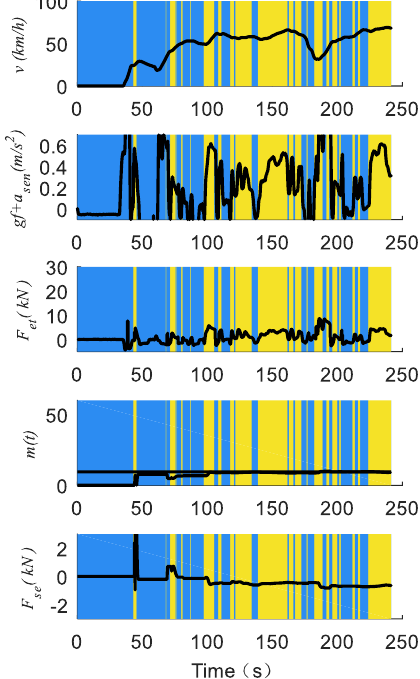
Figure 6. One set of the no-trailer test.